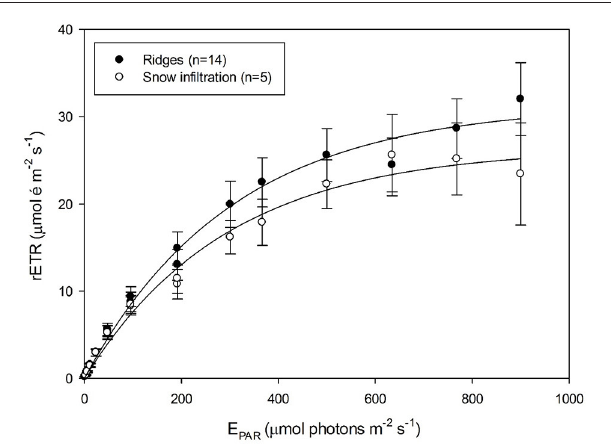
FIGURE 9 | Rapid light curves from ridge (black circles) and snow infiltration (white circles) communities measured with PhytoPAM. The relative electron transfer rate (rETR) is plotted against photosynthetically active radiation (E PAR ). Average and standard deviation for each light step are shown and the Webb et al. (1974) model was used to fit the average